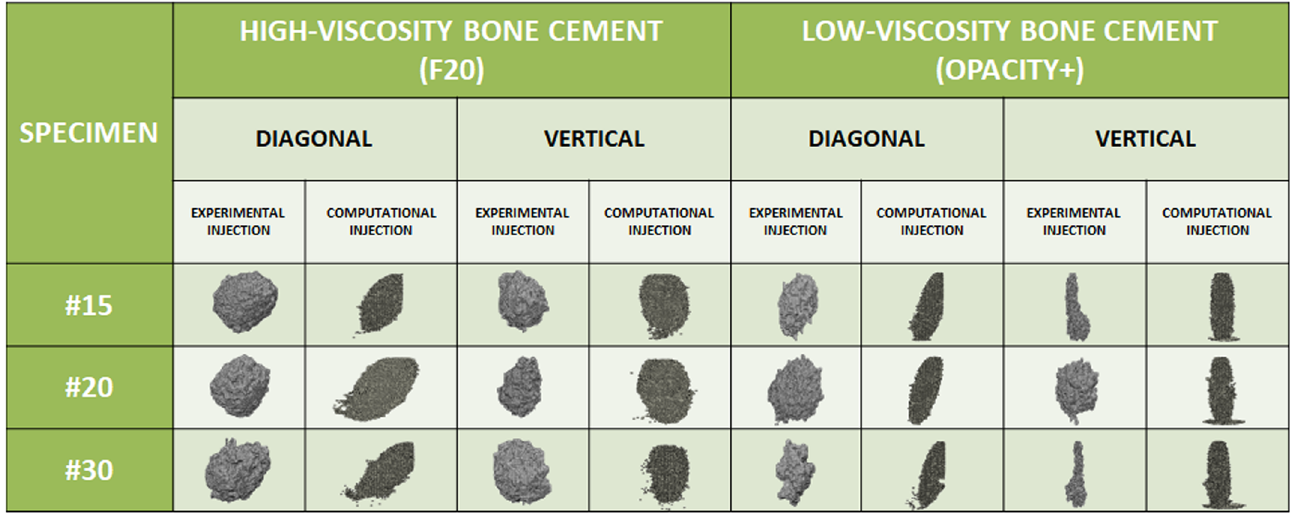
Fig 4. Qualitative comparison of the cement infiltration patterns within certain open-cell structures in each case simulated.